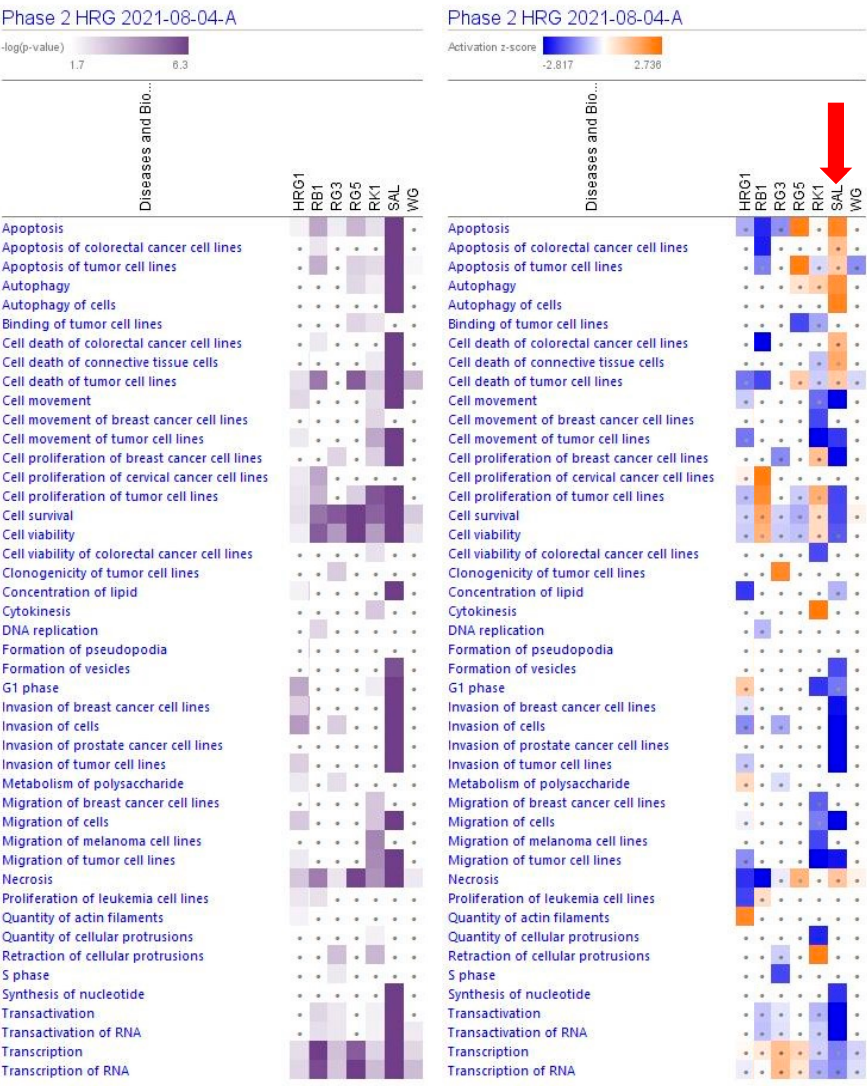
Figure 3. Predicted effects of RG–RS (SAL) at concentrations of 20 μ g/mL, RG at concentrations of 10 μ g/mL (HRG1), white ginseng (WG), and ginsenosides Rb1, Rg3, Rg5, Rk1 at a concentration of 0.1 μ M. The violet color shows the p -value (calculated using a Right-Tailed Fisher’s Exact Test), indicating the statistical significance of the overlap of analyzed dataset genes within the diseases; the intensity of color corresponds to the log p -value in a scale from 1.7 to 16.2 (upper panel). Disease scores are shown using a gradient from dark blue to brown for predicted activation and light to dark blue for predicted inhibition of diseases on a scale from − 2.817 to +2.736 (upper panel); symbol · shows that the activation z-score was < 2, and the − log p -value <1.3 = p < 0.05. An absolute z-score ≥ 2 is considered significant activation (+) or inhibition (-).